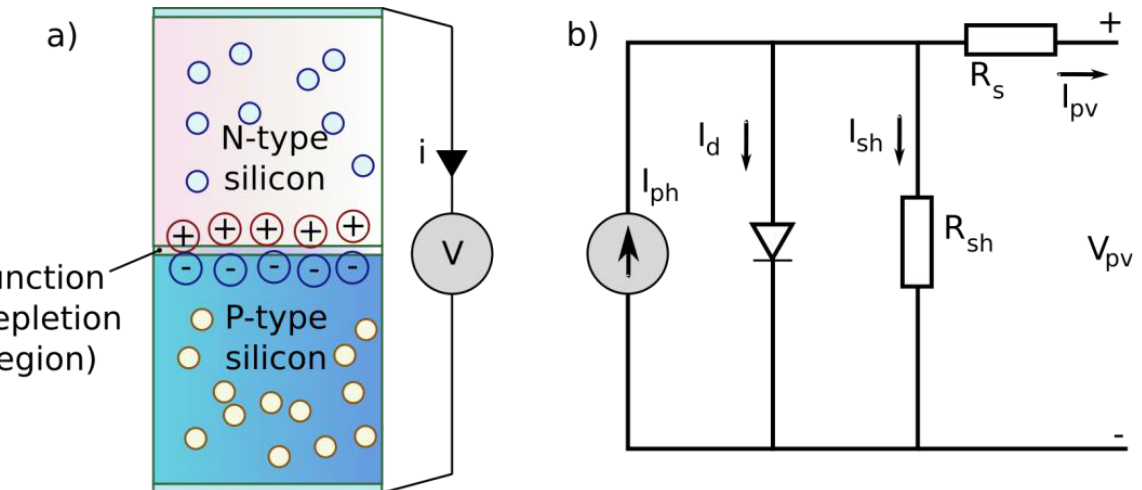
Figure 15. ( a ) Photovoltaic cell working principle; ( b ) PV-cell-equivalent circuit. From the figure above, an equation can be derived